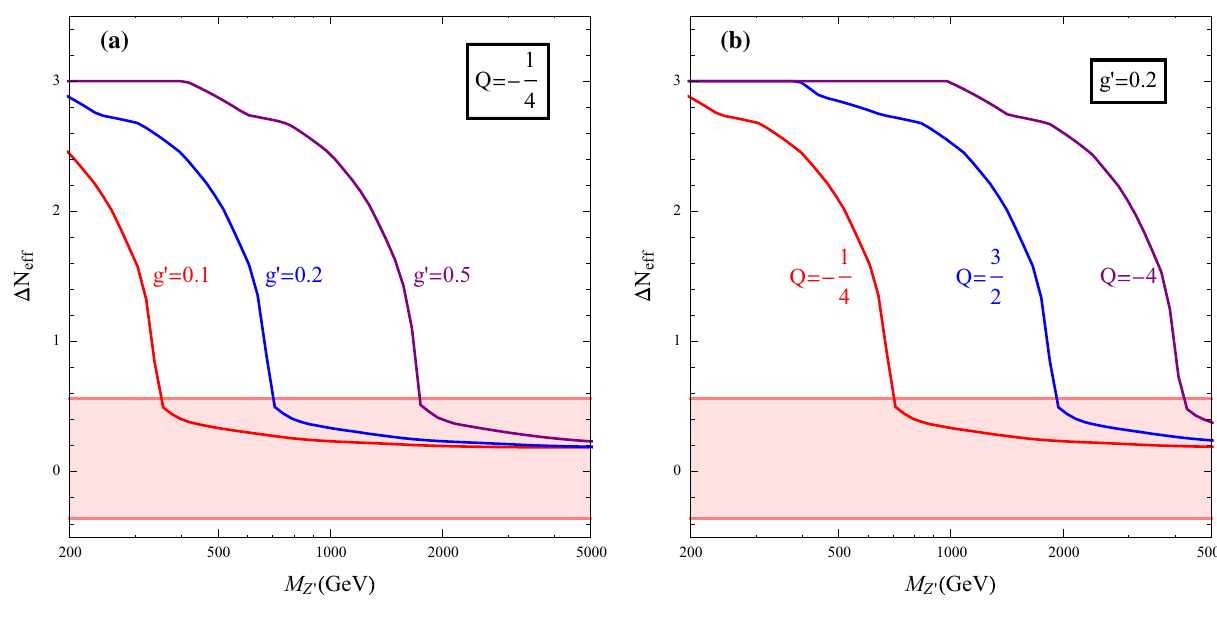
, − 4 , 3 . The shaded pink region is allowed by current 4 2